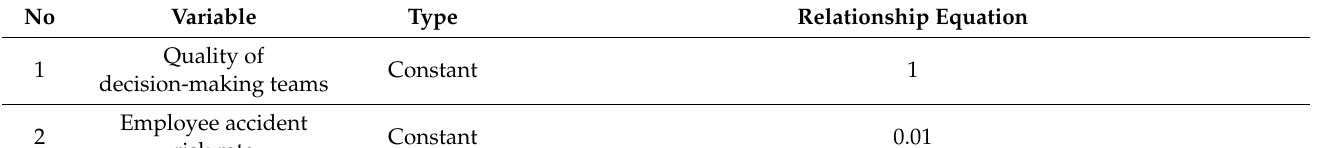
Table 3. Ethical risk variables and equations for AI decision